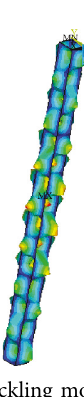
Figure 8: Local buckling modes of components.